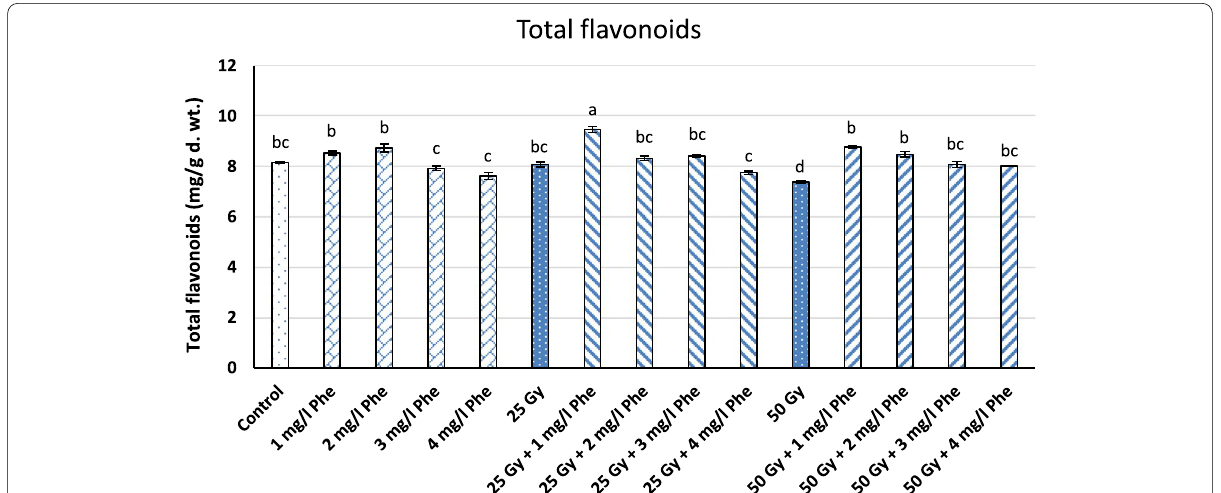
Fig. 3 Total flavonoid content under treatment of diffrent combinations of γ‑radiation (25 and 50 Gy) and Phe (1, 2, 3, and 4 mg/l) in the callus cultures of S. marianum L. Different letters on the bars indicate a significant difference at P